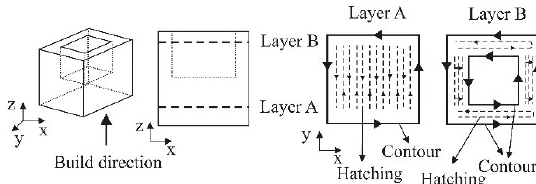
Figure 4. Strategy of manufacturing simple products [13].